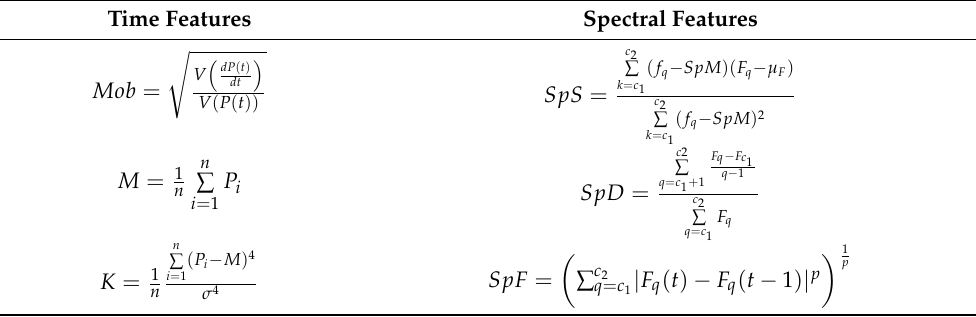
Table 2. Mathematical description of time and spectral features used in this